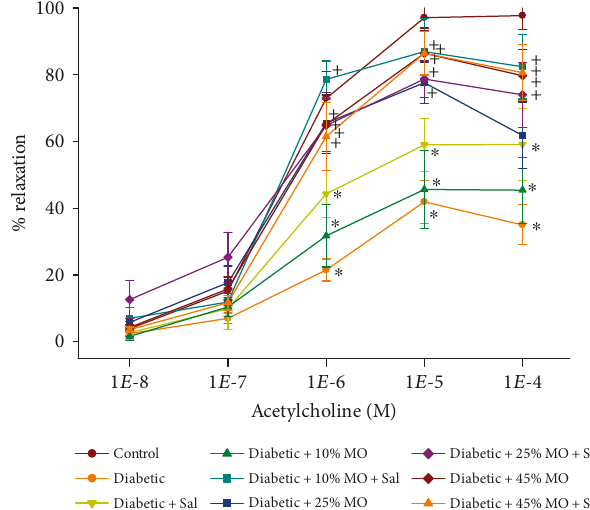
Figure 2: E ff ect of menhaden oil concentration with or without salsalate on vascular relaxation by acetylcholine in epineurial arterioles of the sciatic nerve in Sprague Dawley type 2 diabetic rats. Pressurized arterioles (40 mmHg and ranging from 60 to 100 μ m luminal diameters) were constricted with phenylephrine (30 – 50%), and incremental doses of acetylcholine were added to the bathing solution while recording steady-state vessel diameter. The number of rats in each group was the same as shown in Table 1. Data are presented as the mean of % relaxation ± SEM . ∗ P < 0 05 compared to control rats; + P < 0 05 compared to diabetic